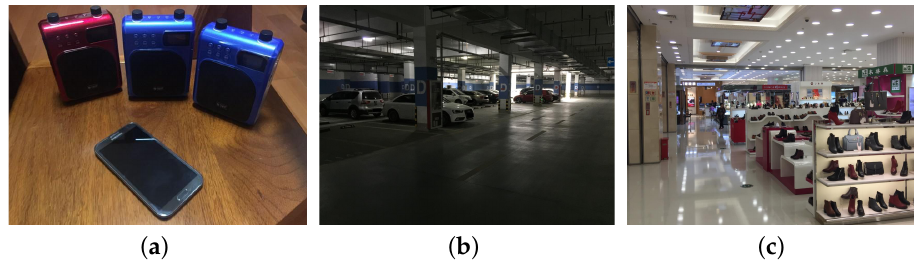
Figure 6. ( a ) experiment devices; ( b ) the underground parking lot; ( c ) the shopping mall.